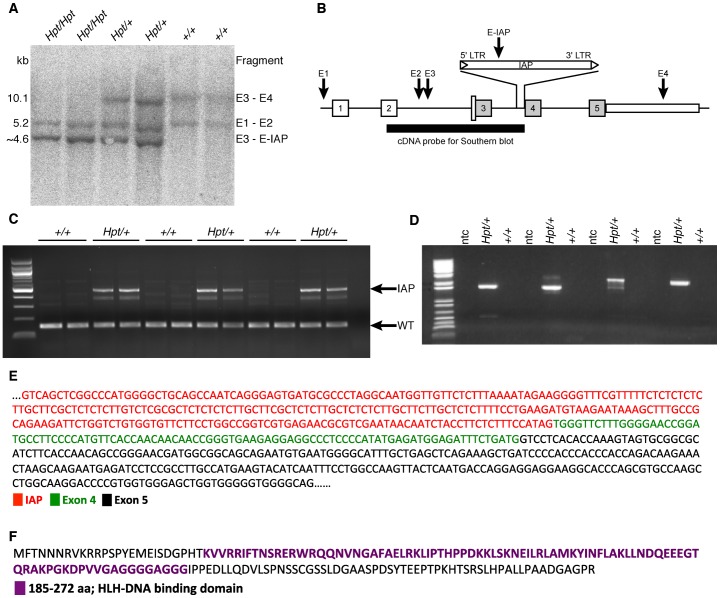

Tal1 Southern blot and IAP insertion.There are 4 EcoRI sites in the murine Tal1 gene (labeled E1–E4). Southern blot was performed on genomic DNA from 15 dpc embryos from Hpt/Hpt, Hpt/+ and +/+ mice using a cDNA probe spanning exons 2–3 (A). Blotting revealed two bands in wildtype embryos: 10.1 kb (fragment E3–E4), and 5.2 kb (fragment E1–E2). Hpt/+ embryos show a third band, at ∼4.6 kb, representing a fragment created by the insertion of a new EcoRI site in intron 4. Hpt/Hpt embryos show only the 5.2 kb and 4.6 kb fragments (B). 1 µg of total RNA was reverse transcribed and PCR was performed to evaluate IAP insertion. Specific primers (Tables S3&4) were used to amplify exons 3 and 4, and IAP and exon 5 (C and D). Whereas the higher molecular weight band in Hpt/+ indicates IAP insertion, the lower molecular weight indicates wildtype transcript (C). Four primer sets flanking IAP and exon 5 were used on 17-day-old Hpt/+ and +/+ kidney cDNA to ascertain if there was a fusion product of IAP RNA with subsequent exons. ntc, no template control (D). When the product of primer set 1 (Table S4) was sequenced, the 3′ end of the IAP was spliced with exon 4 and part of exon 5 (E). Shown is the protein product that might result from using the alternative translation initiation site in exon 4, which is downstream of the IAP insertion (F).